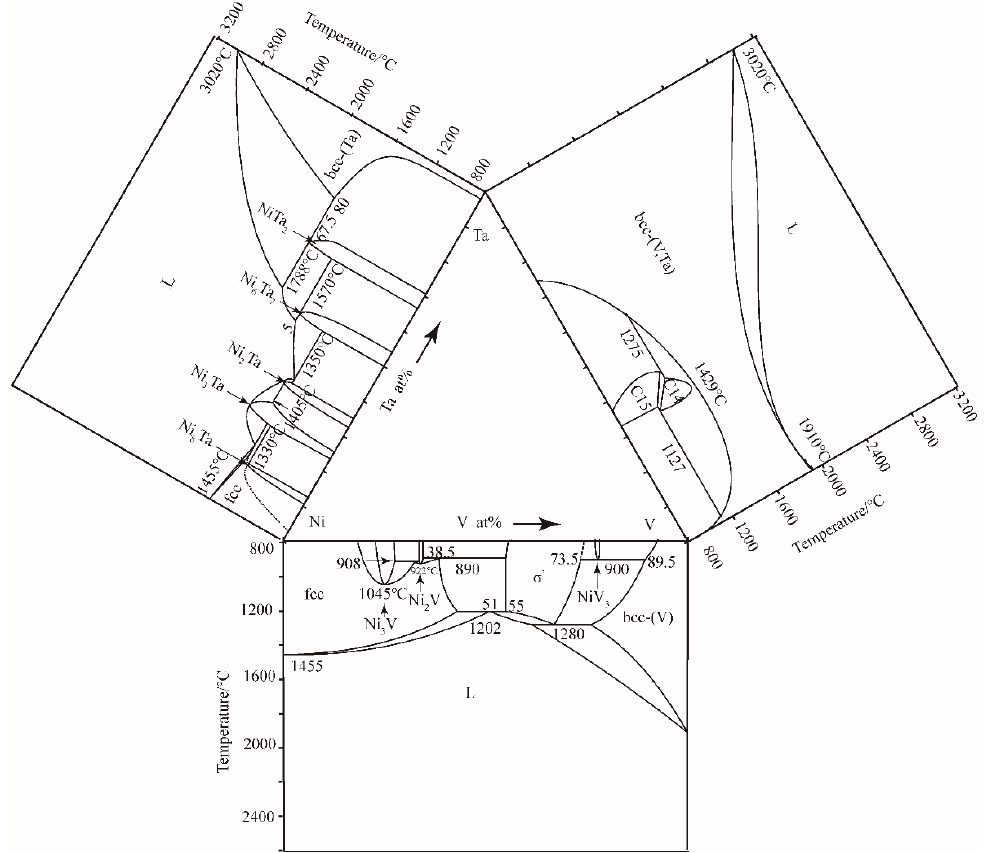
Figure 1. Binary phase diagrams constituting the Ni-V-Ta ternary system. Data from [16,24,30].